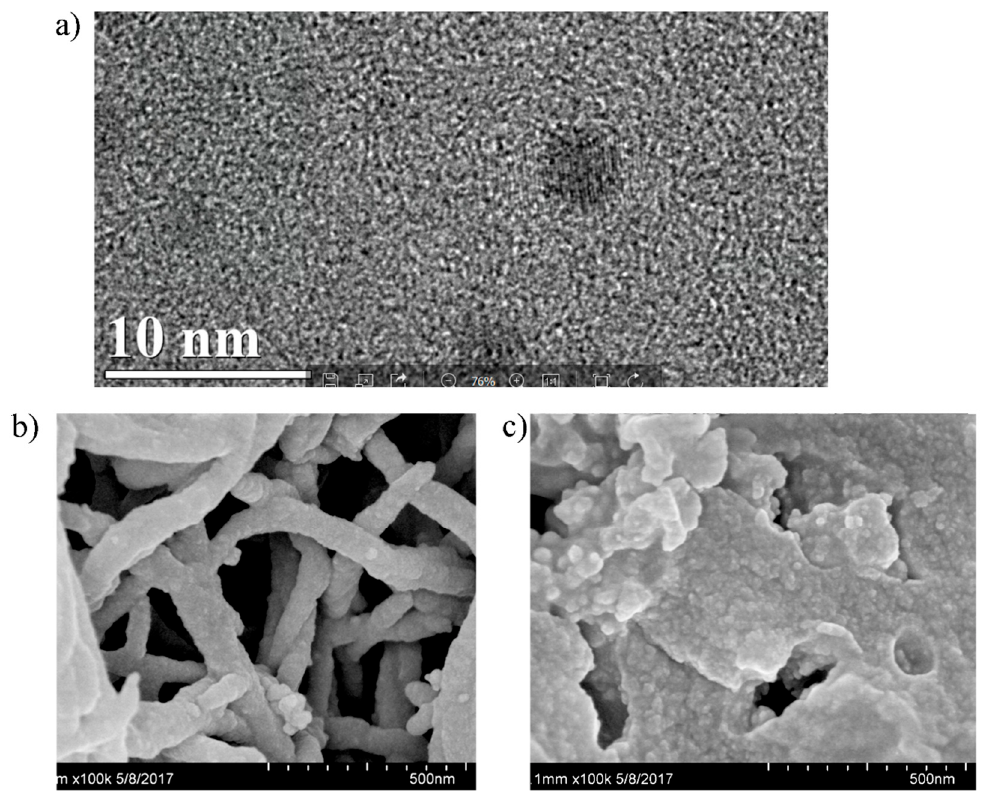
Figure 2. ( a ) TEM image of CdSe / ZnS QDs, ( b ) SEM image of COFs, ( c ) SEM image of QDs-grafted COFs.